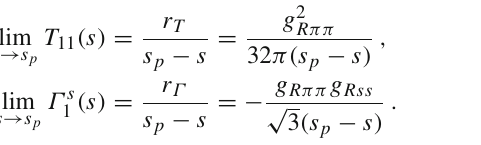
for the fits with an additional ρρ (top) and σσ (bottom) channel. Fit 1 is shown √ 2 s in the ¯ B 0 s